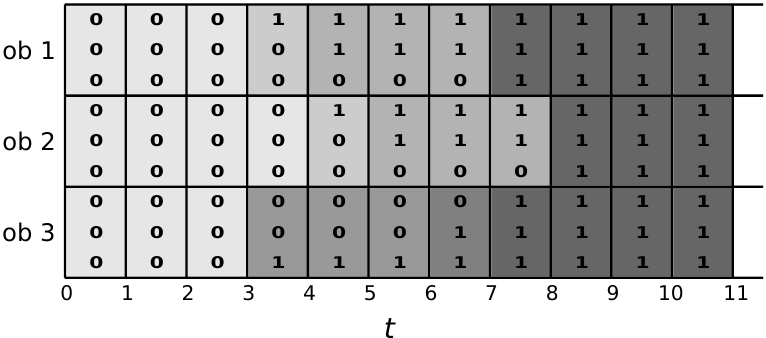
Figure 2. A simple example where three jobs have to execute on one machine. There are three solutions and the completion times of the jobs on each machine are different for the three solutions (first occurrence of a 1). The first row of binary values for each job shows the values of the variable in the first solutions. In the first solution, for example, job 1 completes at time point 3, job 2 at time point 4 and job 3 at time point 7. Moreover, the variable for job 1 at time point 5, for example, has value 1—that is, z 1,5 = 1. The same holds for the second solution. However, variable z 1,5 has value 0 for the third solution.